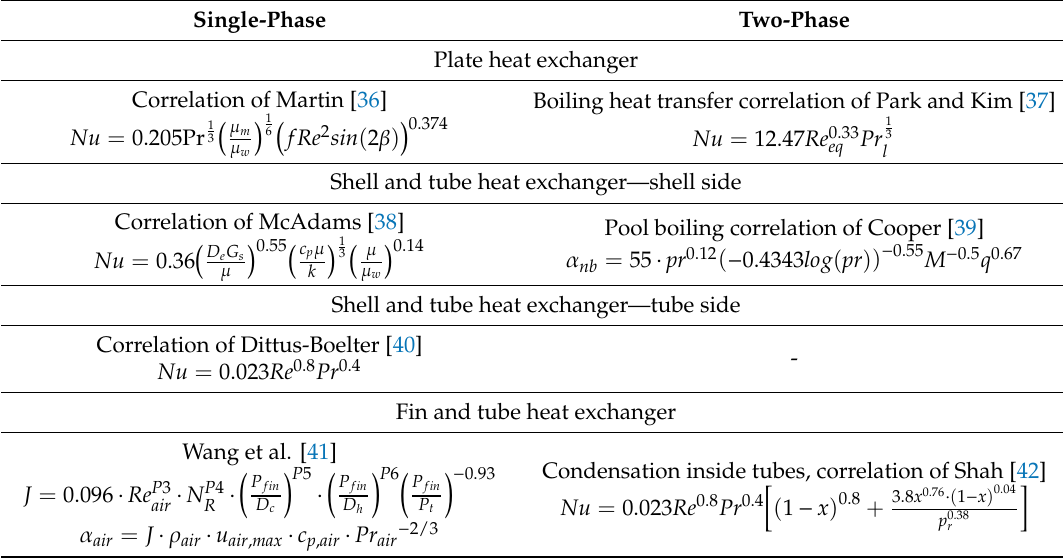
each heat exchanger type in Appendix B. Table 3. Single-phase and two-phase heat transfer